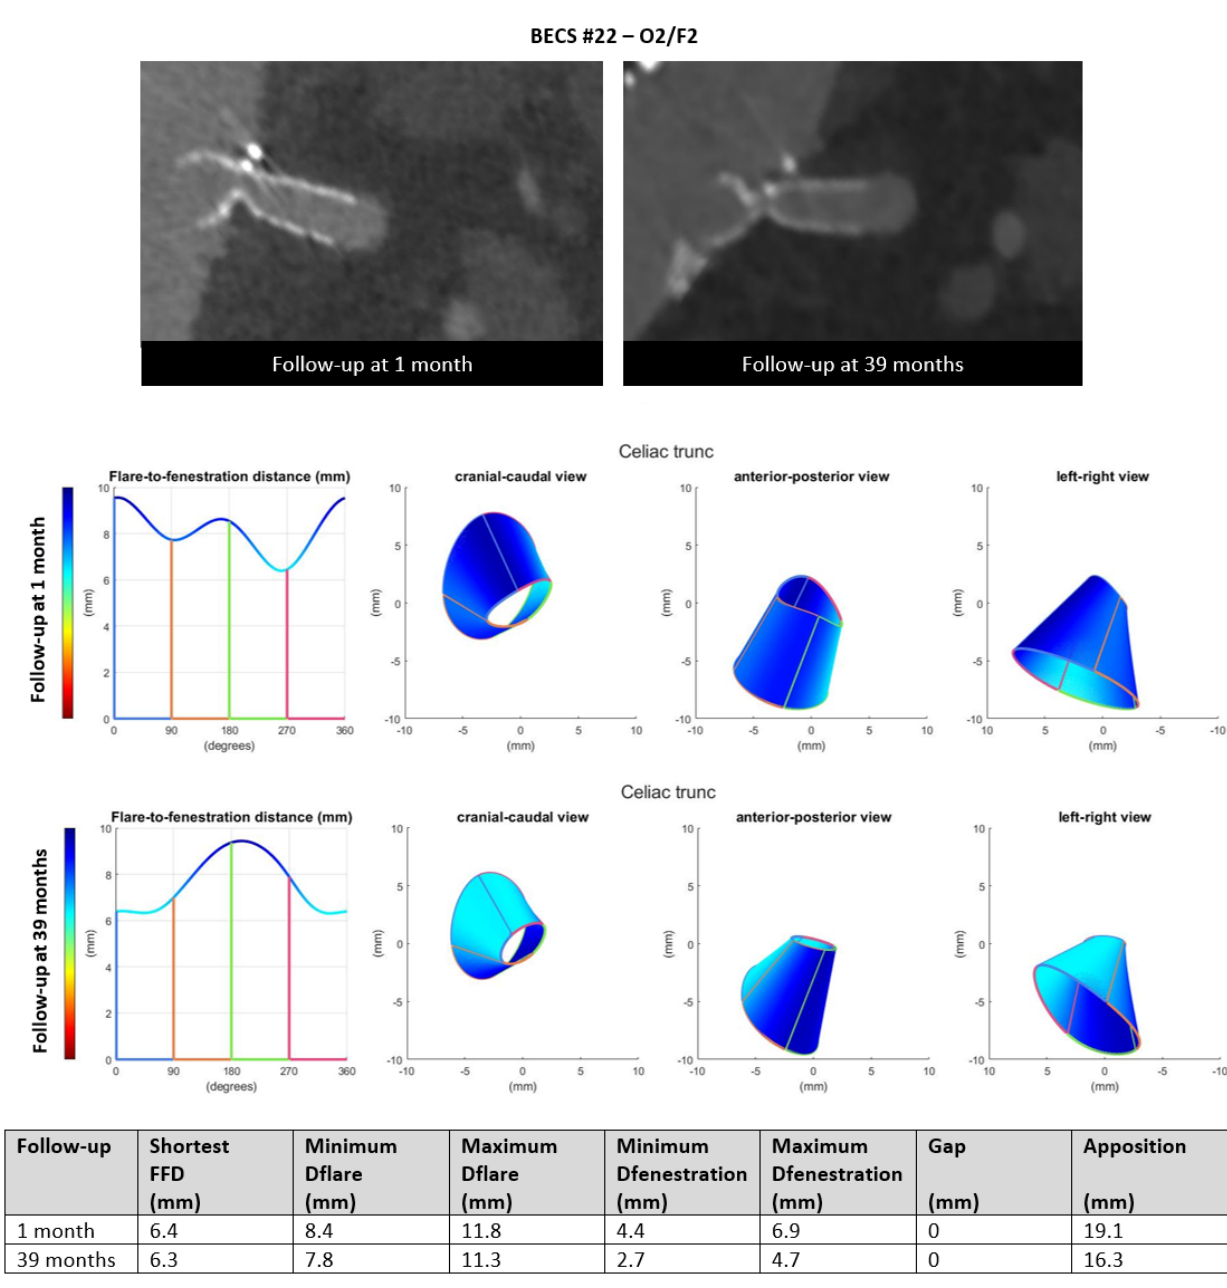
Figure 8. BECS #22 is an example of O2, combined with F2, obstruction due to compression at the fenestration and fracture of multiple struts. At the top, the snake view of 1-month and 39-months post FEVAR-CTA scans—at the bottom, geometric analysis of both follow-up moments, confirming the decreasing diameter at the height of the fenestration.